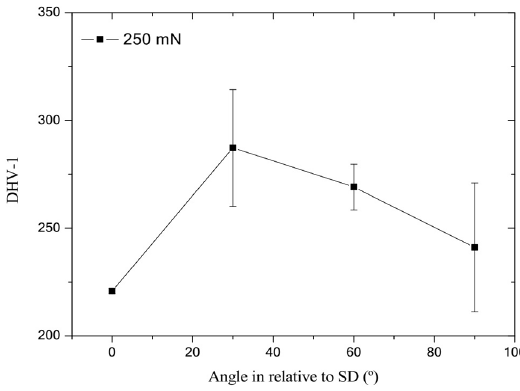
Figure 5. DHV-1 hardness as a function of solidification